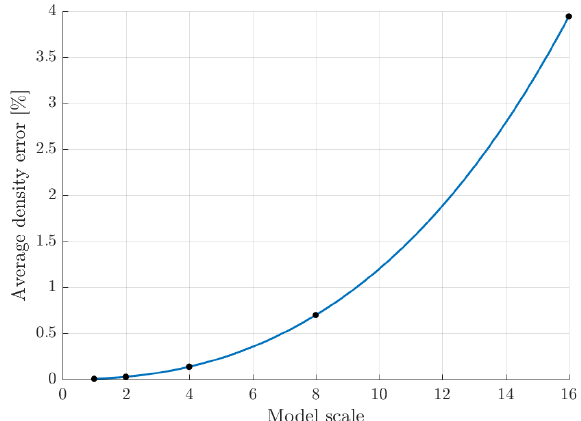
Figure 7. Average sample relative density during sintering